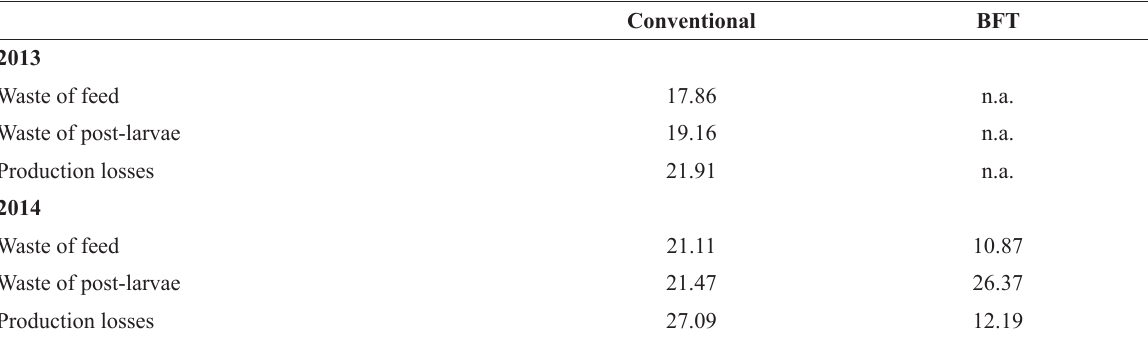
Percentage of wastes (feed and post-larvae) and production losses in 2013 and 2014 verified through data envelopment analysis with constant returns to scale and input/output orientation of the conventional and biofloc (BFT) systems in a farm located on the coast of Pernambuco,